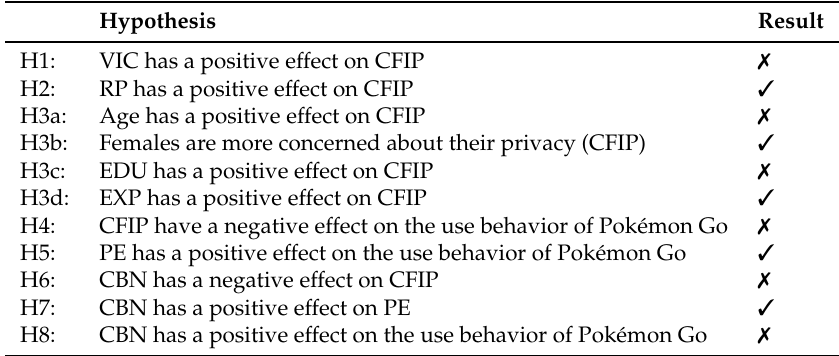
Table 2. Summary of the